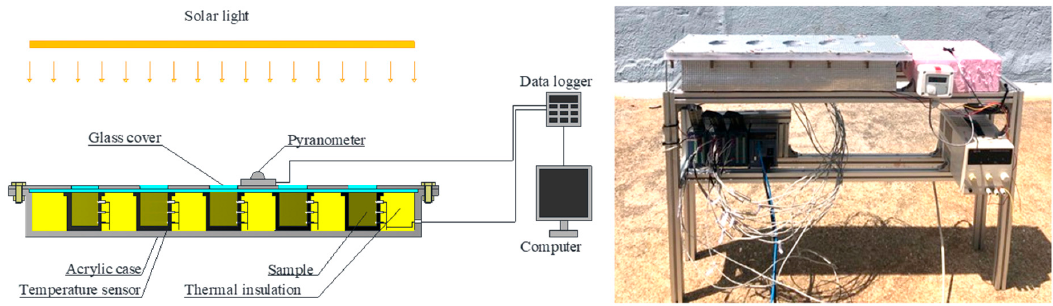
Figure 5. Schematics and picture of photo-thermal energy conversion experimental setup.